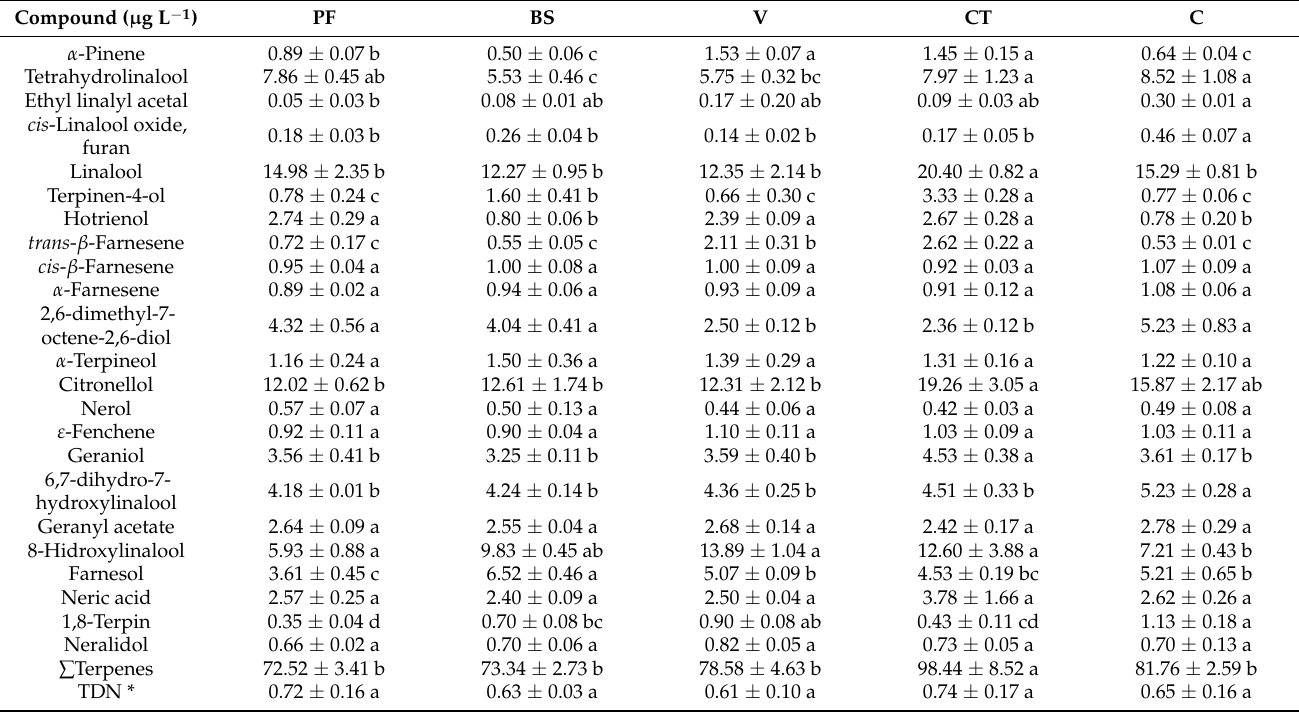
Table 2. The concentrations of varietal aroma compounds of Maraština wines subjected to defoliation and cluster-thinning